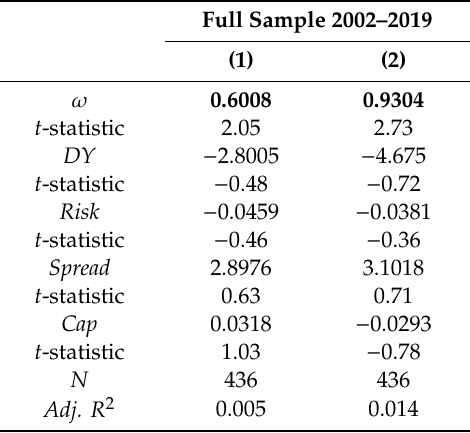
Table 4. Regression of PDR on control